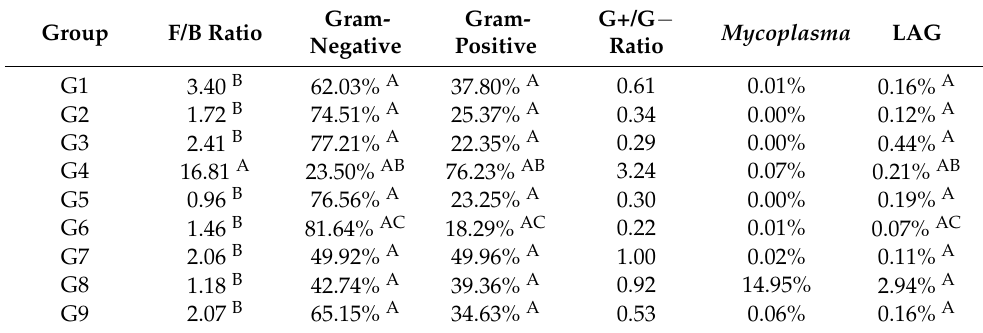
G1: negative control group, G2: high fat diet (HFD), G3: cefriatoxane HFD, G4: LG-G12 HFD, G5: cefriatoxane + LG-G12 HFD, G6: standard fat diet (SFD), G7: cefriatoxane SFD, G8: LG-G12 SFD, G9: cefriatoxane + LG-G12